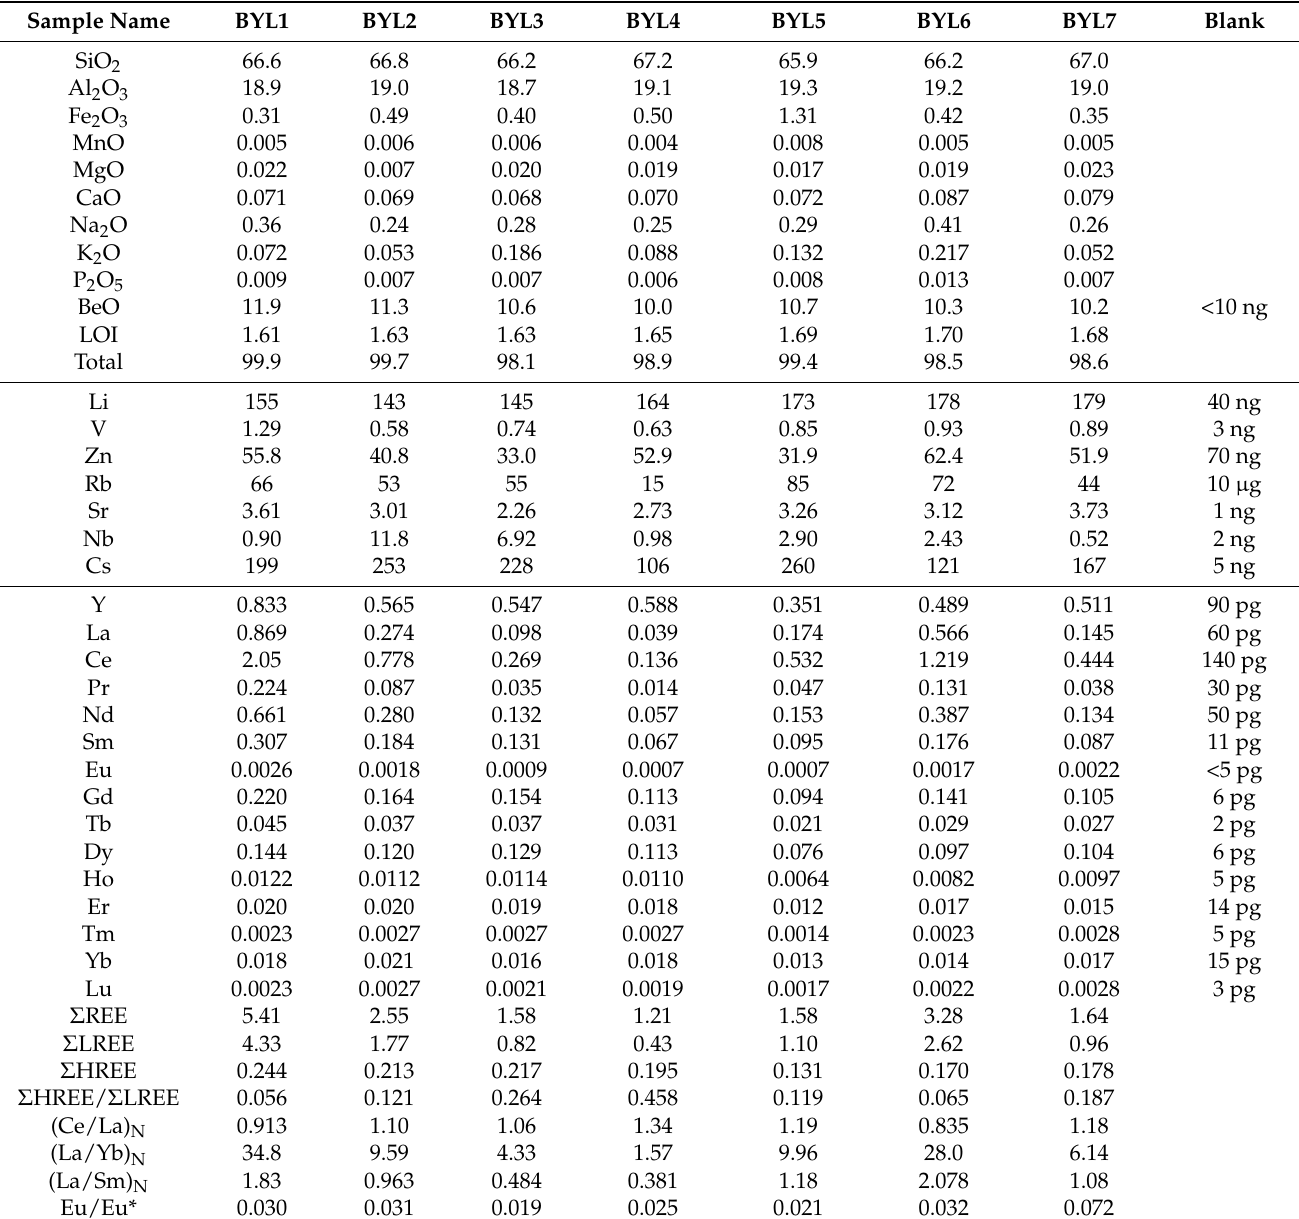
Table 1. Major oxide (wt.%) and trace element concentrations (ppm) of the beryl grains in the Ebrahim-Attar